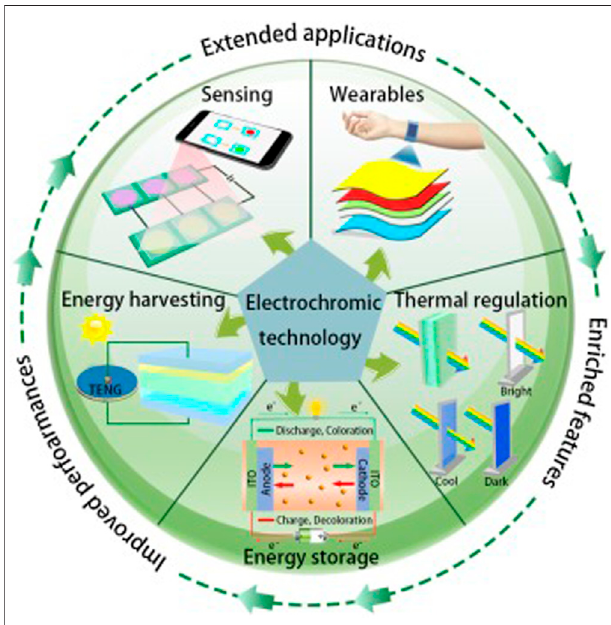
FIGURE 5 | Potential applications of electrochromic technology in greenhouse (Wang et al., 2020).